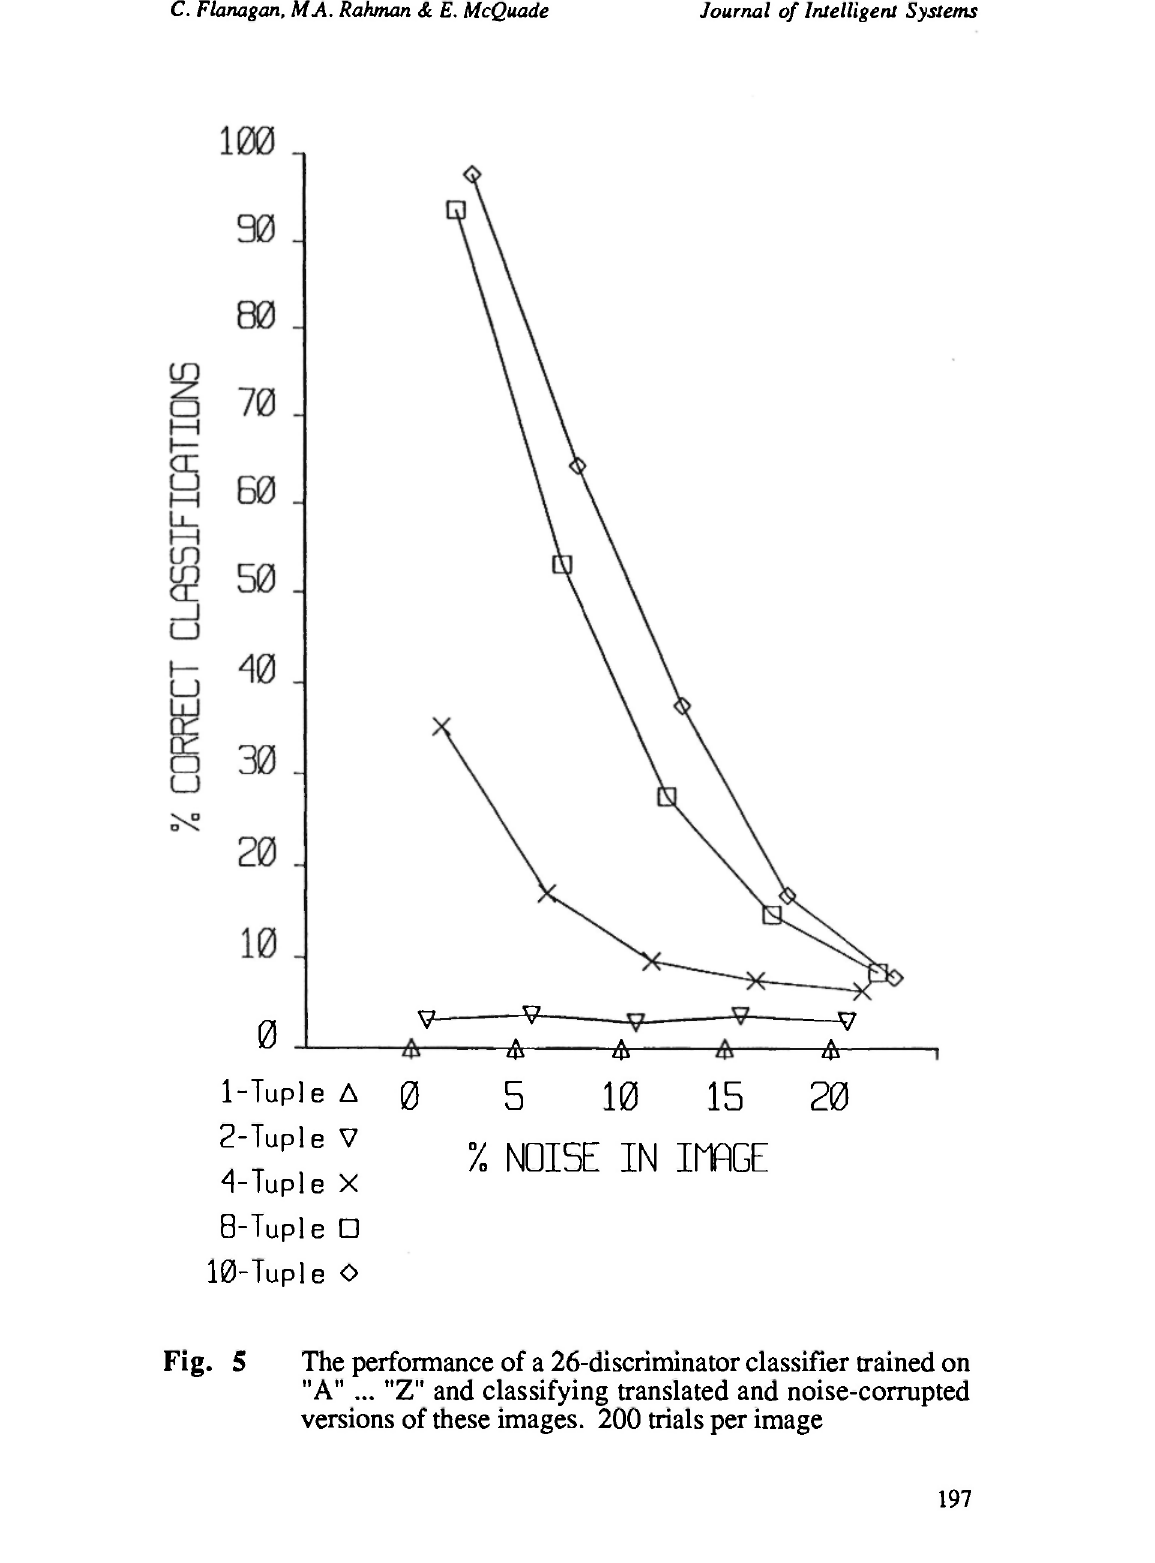
Fig. 5 The performance of a 26-discriminator classifier trained on "A" ... "Z" and classifying translated and noise-corrupted versions of these images. 200 trials per